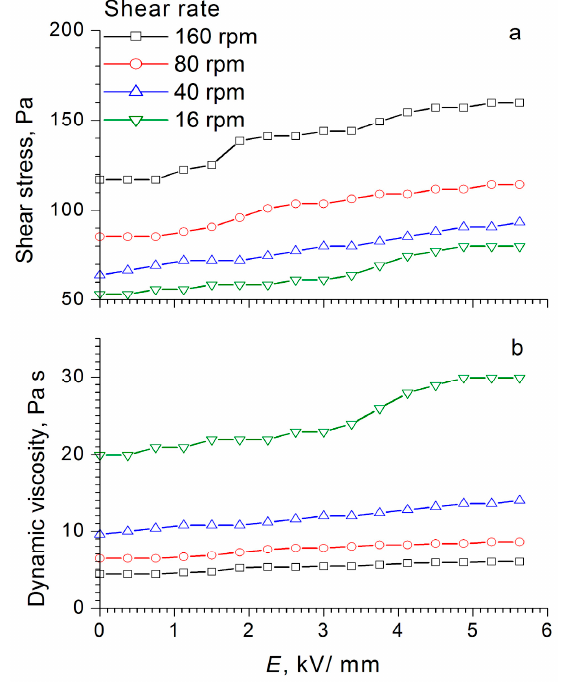
Figure 9. Dependence of ( a ) shear stress and ( b ) dynamic viscosity of the electrorheological fluid containing 60 wt% WO 3 /SDS on the electric field strength, at different shear rates.